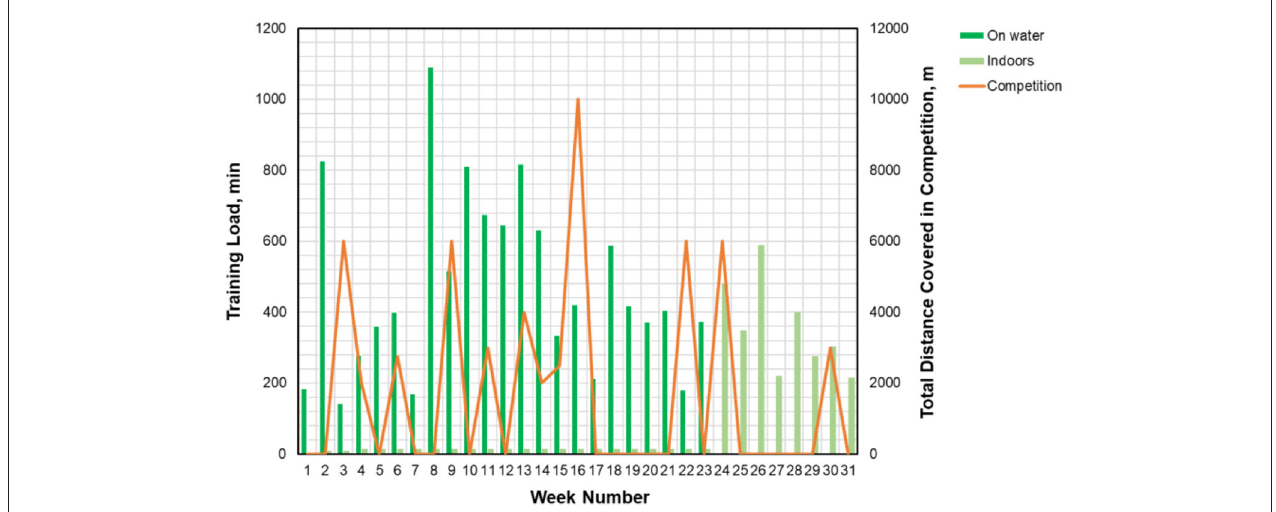
FIGURE 1 | Training program undertaken throughout the study period. Electronic exercise diary (www.sportlyzer.com) was kept for water and ergometer training hours throughout the study period. On the left y -axis—training load in minutes per week, min/week (Rowing on the Water and Indoors ); on the right y -axis—distance in meters per week, m/week ( Competition/m ); on the x -axis—duration of the study period in weeks. Samples for microbiome analysis were taken at weeks 1, 27, and 31. On water , training on the water; Indoors , training on rowing ergometer; Competition , competition calendar of the